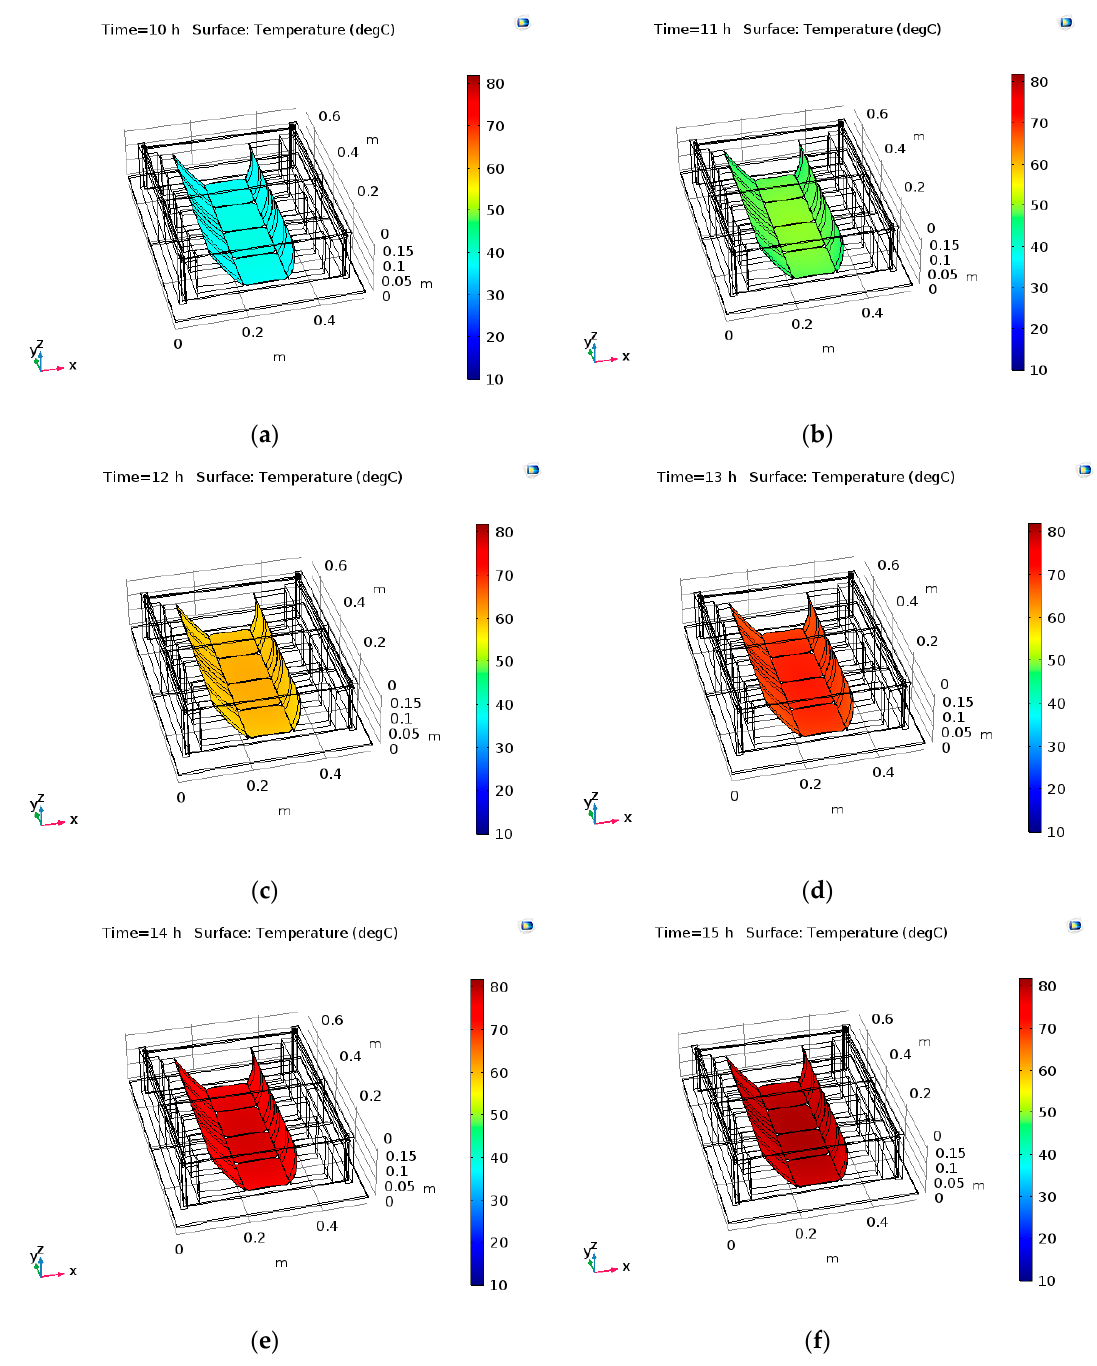
Figure A3. Temperature field on solar cells and reflectors surfaces for the covered CPC scenario (17 July 2017) at the following times: ( a ) 10:00; ( b ) 11:00; ( c ) 12:00; ( d ) 13:00; ( e ) 14:00; ( f ) 15:00.